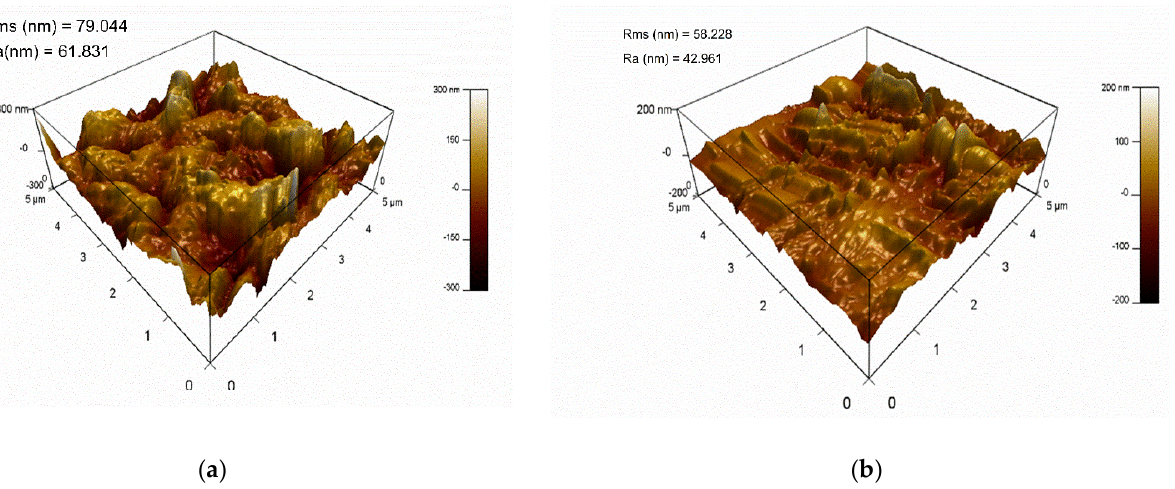
Figure 6. AFM pictures of ( a ) the TFC nanofiber membrane sample and ( b ) the TFN nanofiber mem- brane sample with 0.05−GQD/PA TFN. membrane sample with 0.05 − GQD/PA